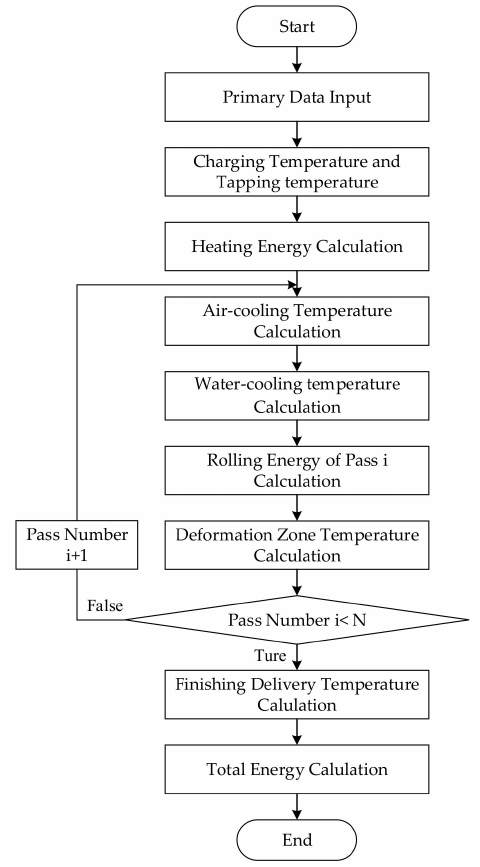
Figure 2. Flow chart of total energy